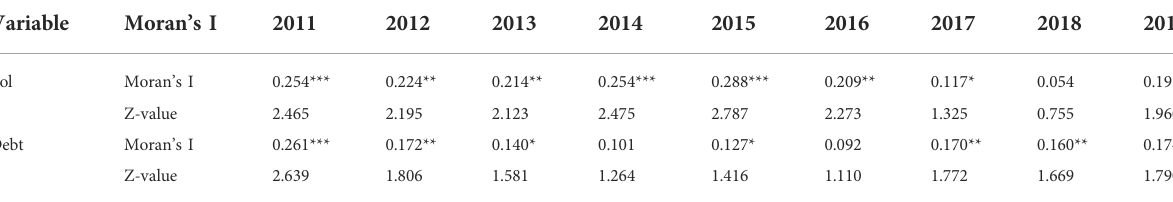
TABLE 4 Global correlation test: Moran index.